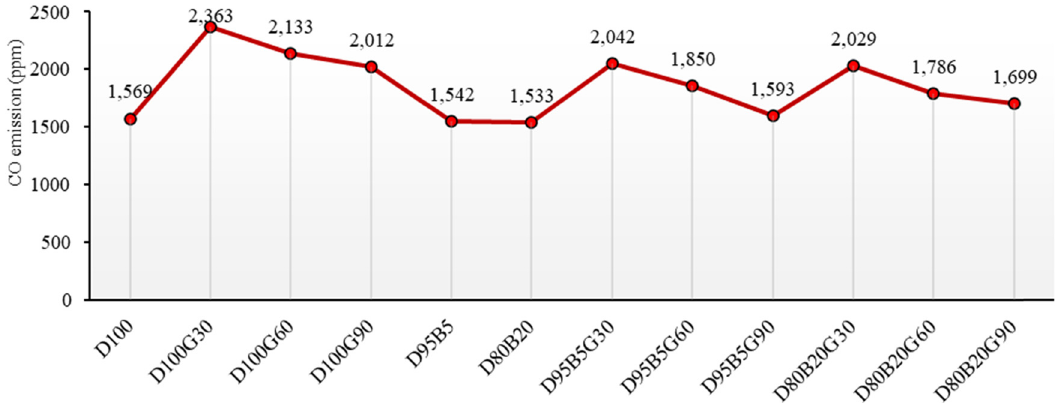
Figure 6: Variations of CO emission for di ff erent fuel